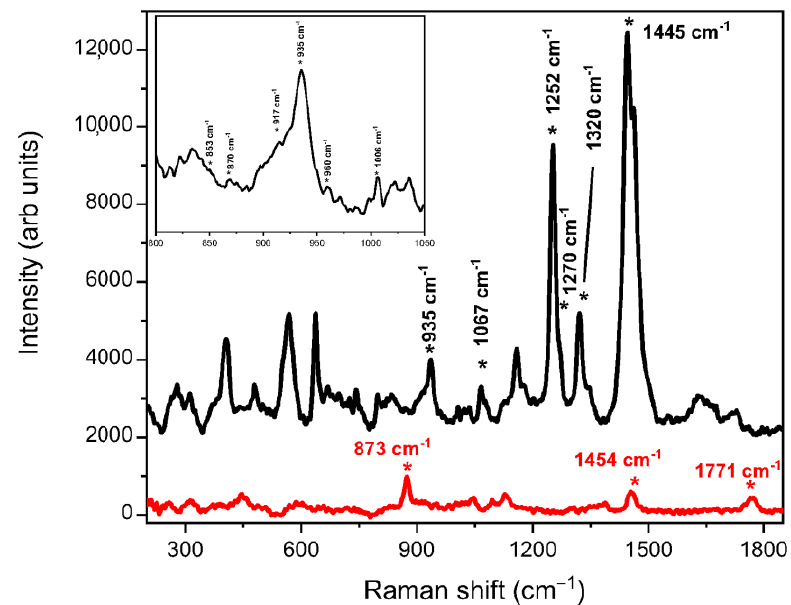
Figure 9. Raman spectra of the pristine PLA scaffold (red line) and of the cell deposited on PLA (black line) and cultured for 7 days. Lorentzian profiles have been adopted to separate the vibra- tional contributions of the amorphous calcium phosphate at 935 cm −1 and of calcium carbonate at 1065 – 1070 cm −1 and fit the experimental data. In the inset, the Raman spectrum of cells deposited on PLA is highlighted in the range between 800 and 1050 cm −1 . The symbol * indicates the peak position for which the centre-frequency value is indicated.